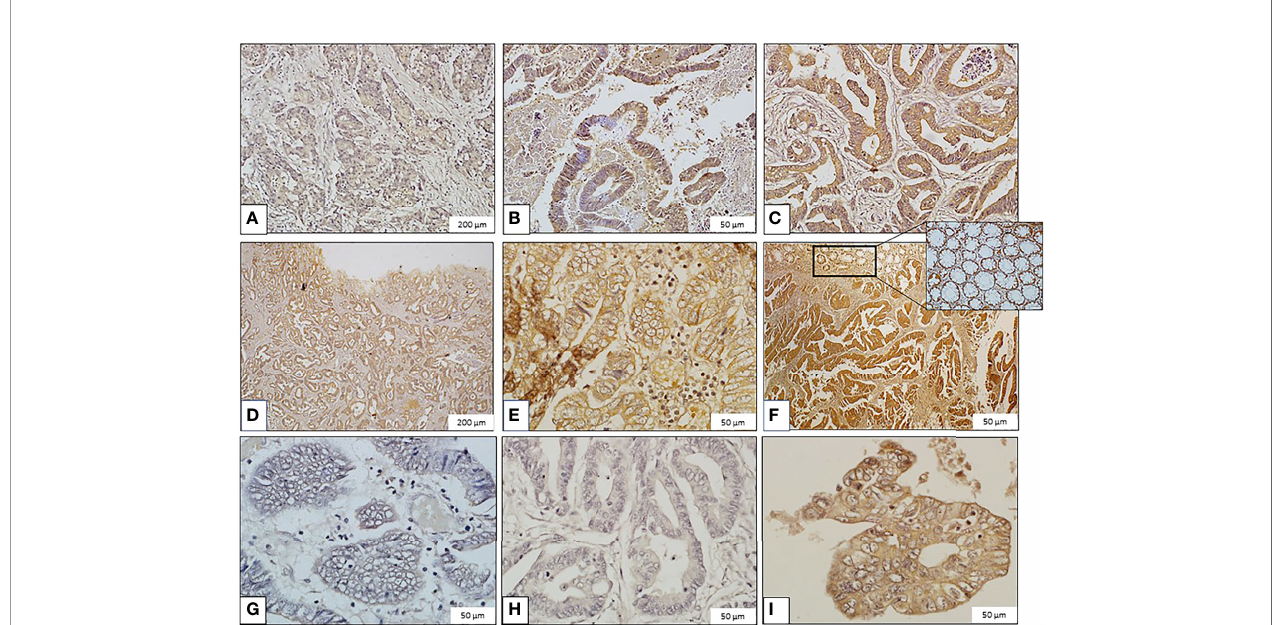
FIGURE 1 | Images of immunohistochemical staining of galanin in colorectal carcinoma (CRC) samples (Immunoperoxidase, scale bar: 200 m m ‘ panels A , D ’ and 50 m m ‘ panels B , C , E , F – I ’ ). Galanin Expression: (A) Mild expression in grade II, stage I CRC. (B) Moderate expression in grade II, stage I CRC. (C) High expression in grade II, stage II CRC. (D) Mild expression in grade I, stage III CRC. (E) Moderate expression in grade I, stage III CRC. (F) High expression in grade I, stage II CRC. The inset shows galanin expression in normal colonic mucosa. (G) Minimal expression in grade III, stage IV CRC. (H) Mild expression in grade II, stage IV CRC. (I) Moderate expression in grade II, stage IV CRC.